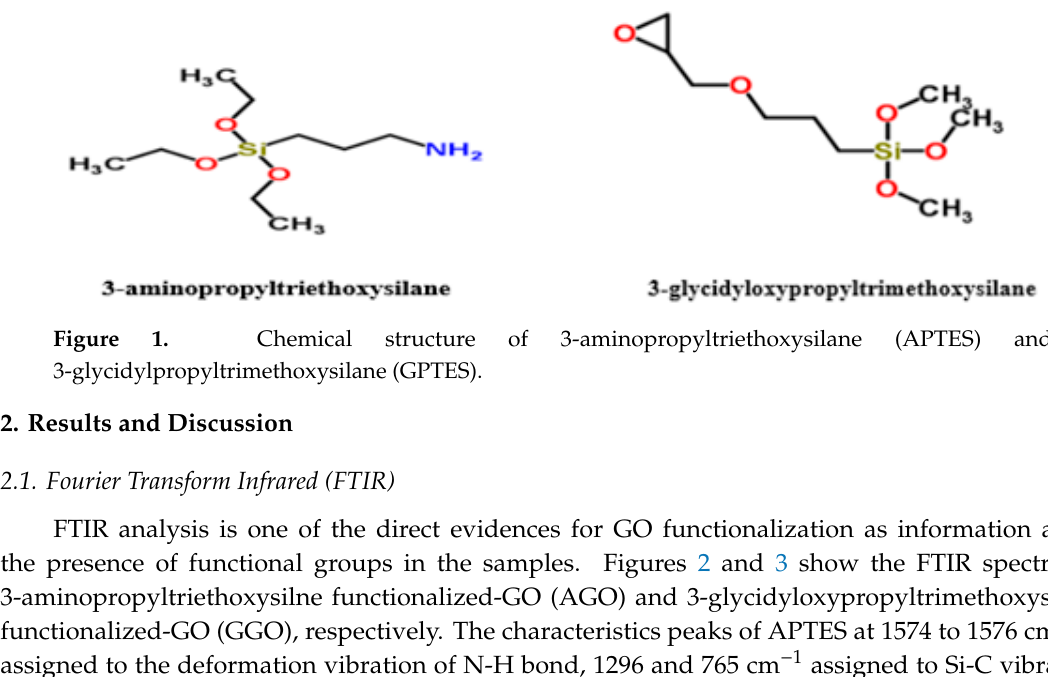
Figure 2. FTIR spectra of GO and 3-aminopropyltriethoxysilne functionalized-GO (AGO-50, AGO-100 and AGO-150).